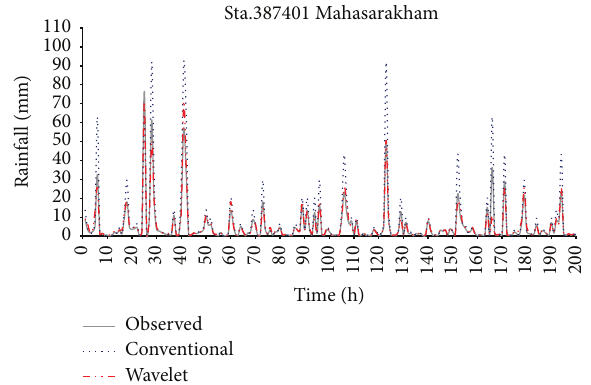
Figure 8: Time series plot of mean observed rainfall at sta.387401 Mahasarakham compared with conventional and wavelet filters technique.